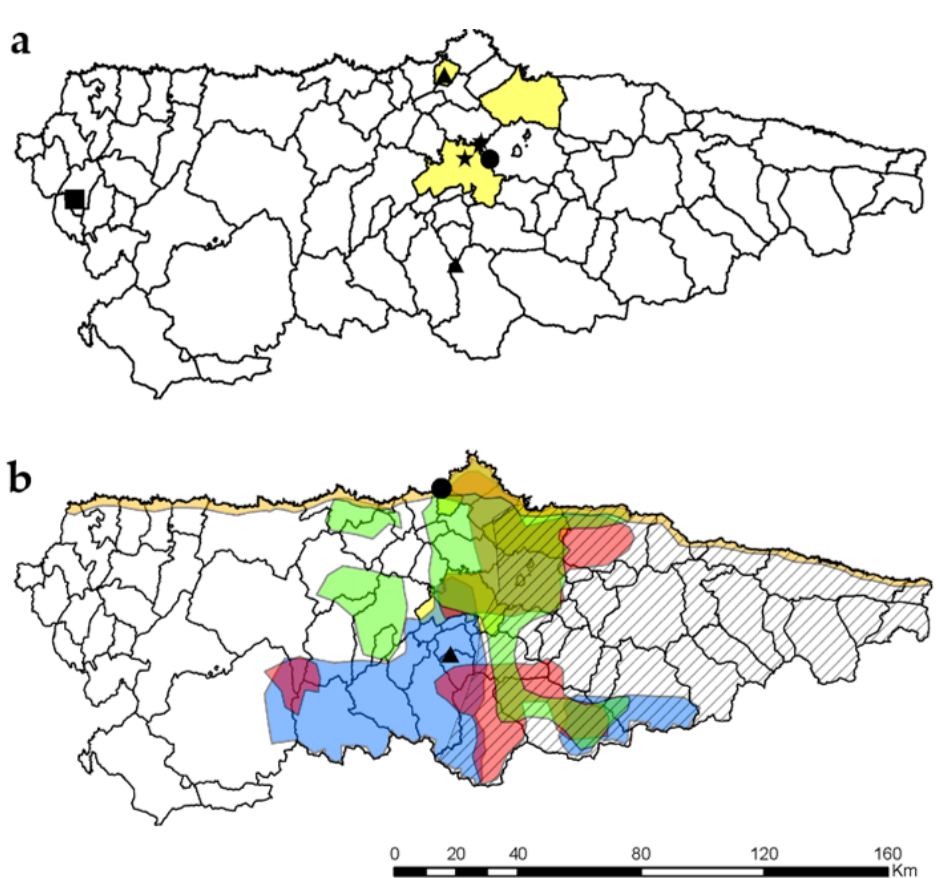
Figure 12. Distribution of parasite-transmitters freshwater molluscs in Asturias. ( a ) Freshwater molluscs: Melanoides tuberculata & Sinoataia cf. quadrata ( ● ), Stagnicola cf. palustris ( ⋆ ), Omphiscola glabra ( ▲ ), Lymnaea stagnalis ( ■ ) and ( b ) terrestrial molluscs: Cochlicella acuta & Theba pisana (orange), Cernuella virgata (green), Xerosecta cespitum (red), Xerotricha corderoi (blue), Monacha cartusiana (stripes), Rumina decollata ( ● ) and Cepaea hortensis ( ▲ ). The municipalities (Avilés, Gijón and Oviedo) with the majority of parasite-transmitters molluscs are indicated in yellow in ( a ).